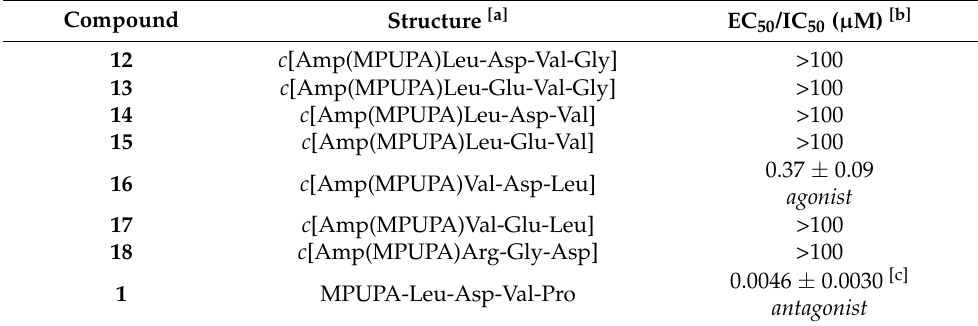
Table 1. Effects of the new Amp-based cyclopeptides on α 4 β 1 integrin-mediated cell adhesion. Compound Structure